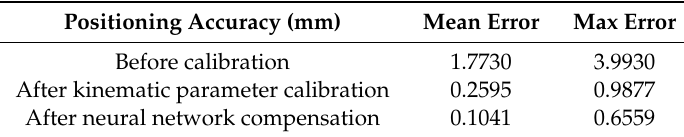
Table 4. Distance accuracy of the experiments.